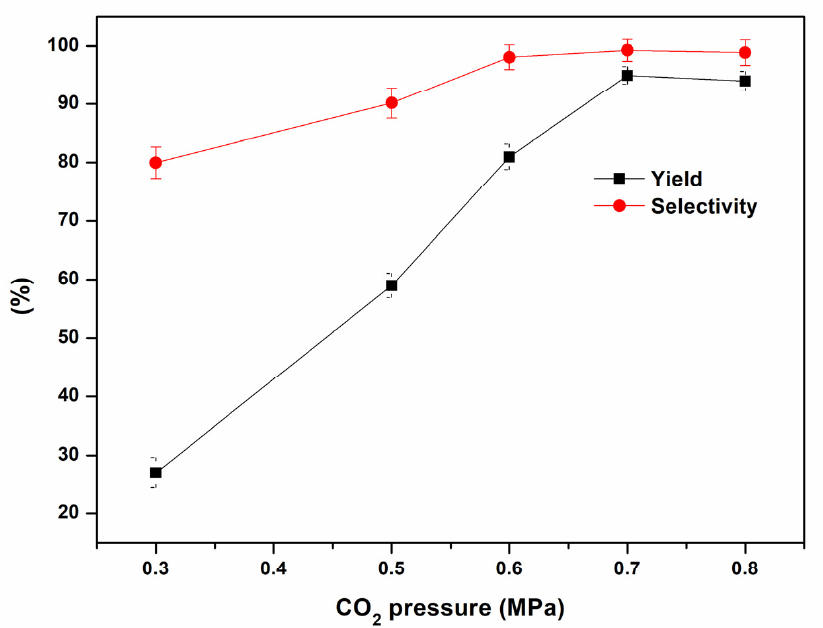
Figure 2. Effect of CO 2 pressure on the reaction. Reaction conditions: 2-methylaziridine (10 mmol), MCM-41@ILLaCl 4 (5%, weight percent based on 2-methylaziridine), 50 ◦ C, 3 h.